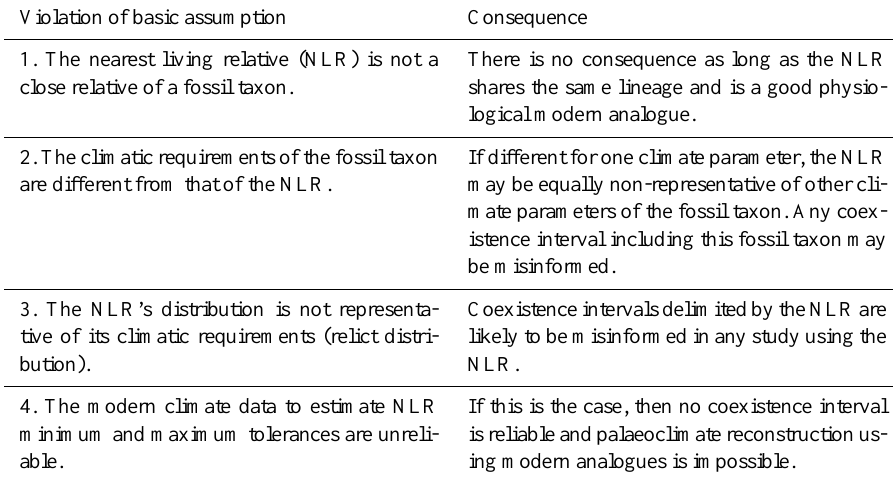
Table 2. The consequences of identifying a climatic outlier in a palaeo-assemblage supposing that these represent violations of one or more of the four basic